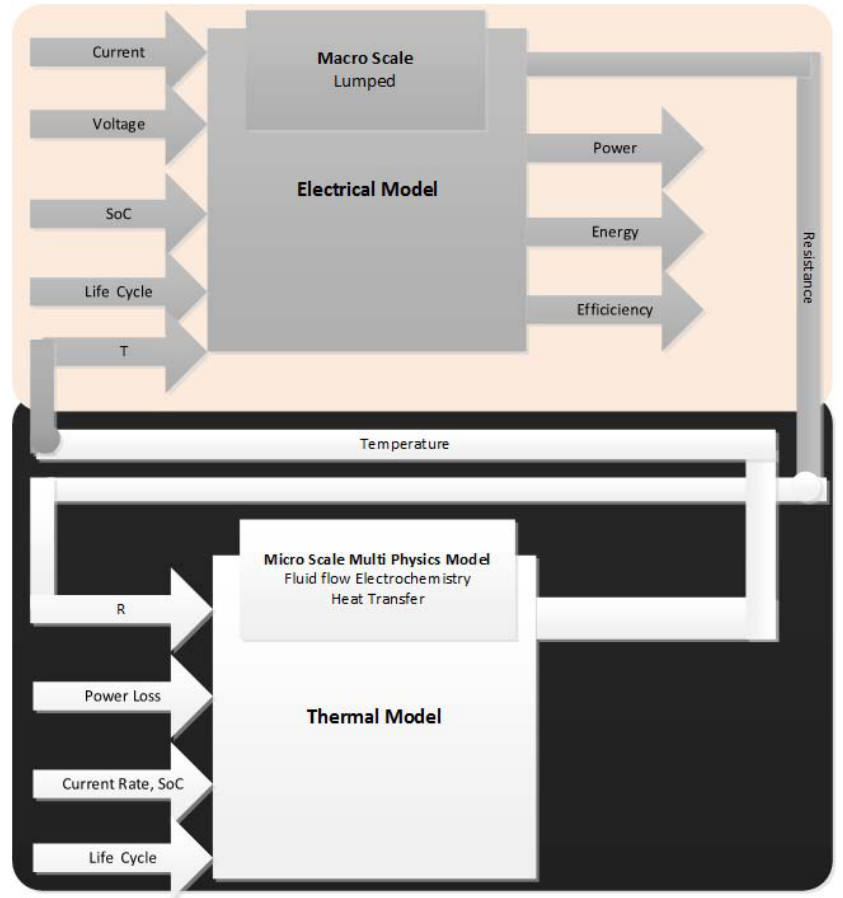
Figure 2. Electrical and thermal model coupling [35].